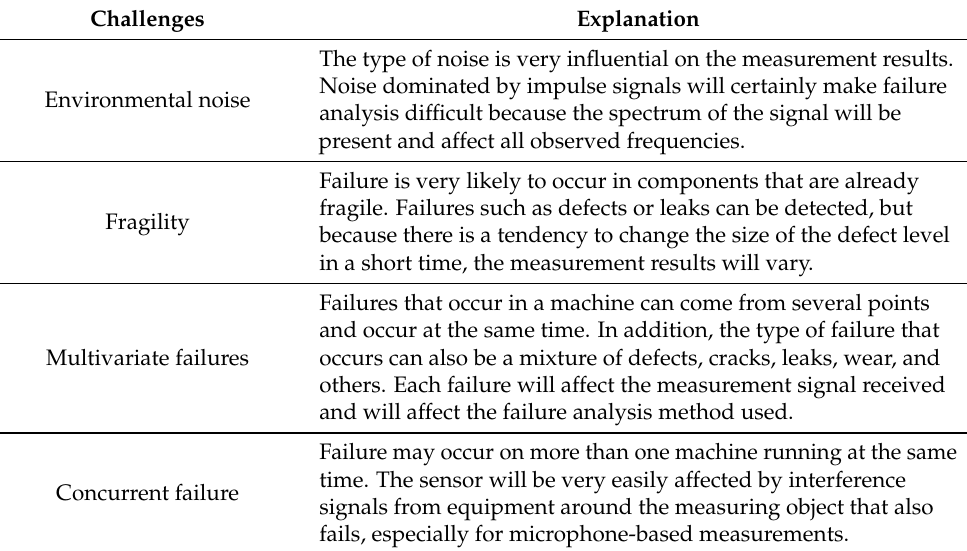
Table 11. Challenges in acoustic-based